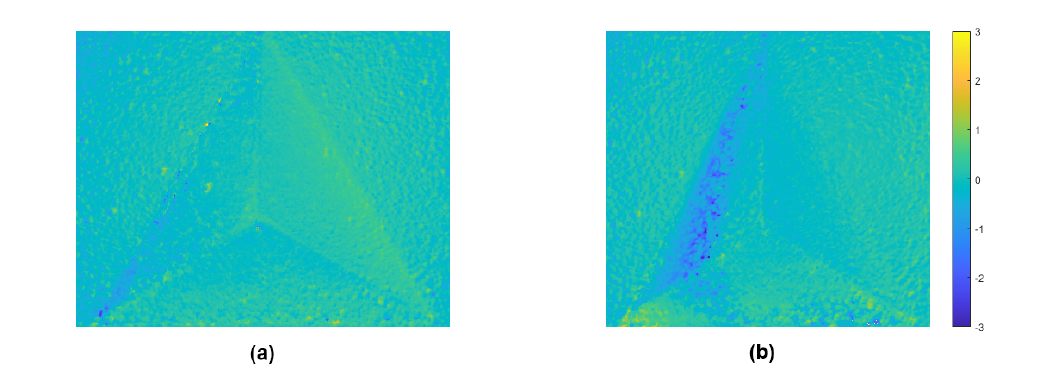
Figure 11. The error maps of both measurements, scaled between − 3 mm and 3 mm deviation. ( a ) stationary measurement; ( b ) scanning